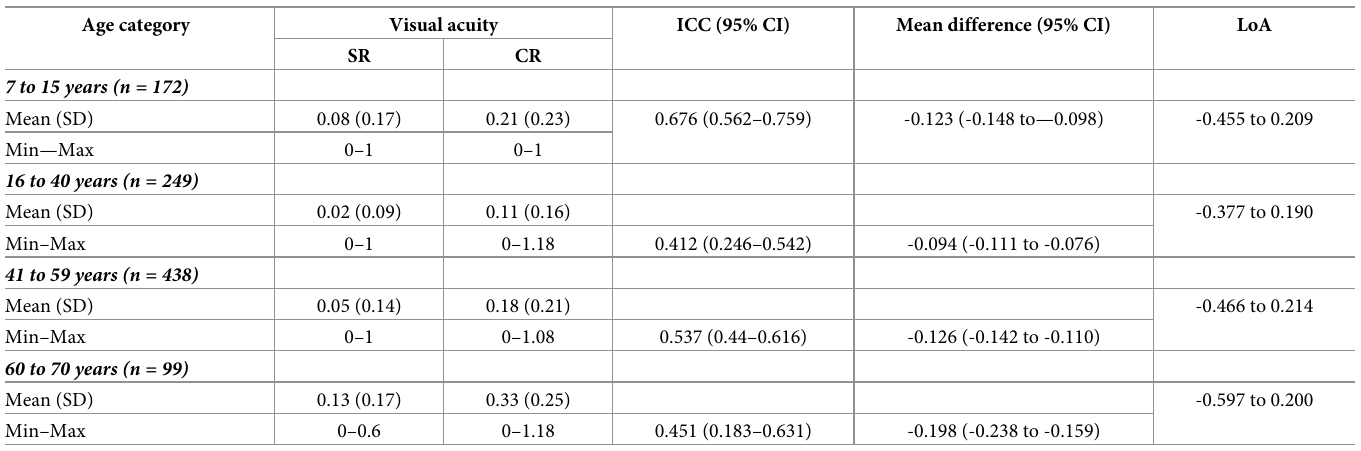
Table 3. VA between SR and CR for various age